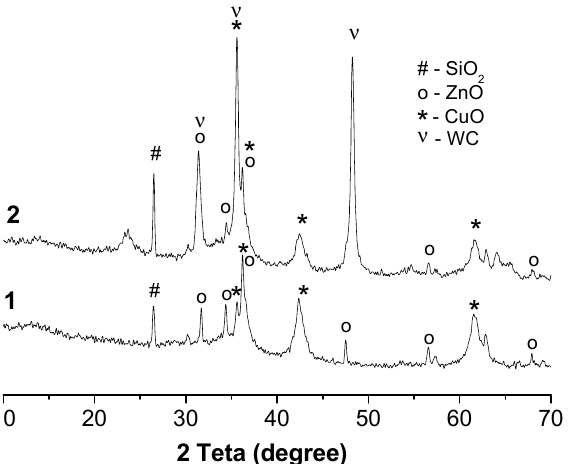
Figure 2. XRD patterns of the CuO-ZnO-SiO 2 ( 1 ) and CuO-ZnO-SiO 2 -WC ( 2 ) catalysts. The DRIFT spectra measured after CO adsorption on two samples before and after catalysis at 200 °C are shown in Figures 3 and 4. The DRIFT-CO spectrum of the initial three-component CuO-ZnO-SiO 2 catalyst demonstrates one narrow band at 2196 cm − 1 . This band characterizes both carbonyl on copper cations (Cu 2+ -CO) and on cations of zinc (Zn 2+ -CO) [11,12]. These complexes are unstable, and the band disappears from the spectrum at room temperature in a vacuum. The spectrum of the initial four-component CuO-ZnO-SiO 2 -WC catalyst exhibits two bands. The band at 2203 cm − 1 with the difference in frequency by 7 cm − 1 (compared to the band at 2196 cm − 1 ) can be ascribed to carbonyls (Cu 2+ -CO) and (Zn 2+ -CO). Alternatively, this band can be attributed to a W n+ -CO carbonyl [13]. It is quite difficult to assign the band at 2127 cm − 1 because it can characterize the carbonyl on copper ions (Cu + -CO) inside the SiO 2 lattice or on the CuO surface [11], as well as oxycarbonyl (Cu + (O) -CO) [14]. In addition, a band with such a low frequency of stretching vibrations was found on a Cu/SiO 2 catalyst modified by sodium [15]. In our case, the role of sodium can be performed by tungsten carbide. Some authors [16] also assigned the band at 2127 cm − 1 to tungsten carbonyl (W n+ -CO).